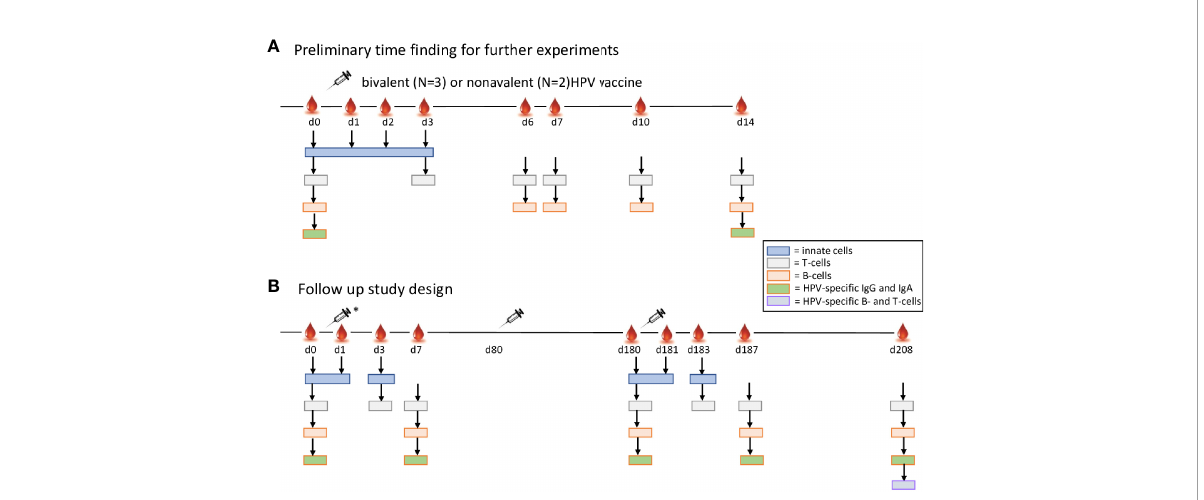
FIGURE 1 Study design. Adult healthy pre-menopausal women (n=20) seronegative for HPV16/18/31/45 received either the bivalent or the nonavalent HPV vaccine according to a three-dose schedule, the second vaccination at 1 month and the third vaccination at 6 months. (A) In the preliminary experiments a blood sample was taken just before vaccination (day 0), and after the fi rst vaccination at day 1, 2, 3, 6, 7, 10 and 14. Numbers of subsets of innate cells (blue), T cells (green), and B cells (red) were studied in 3 bivalent and 2 nonvalent recipients. The arrows indicate the speci fi c time points used per cell type. (B) In the follow up (*) blood samples were drawn of the other 7 bivalent and 8 nonavalent vaccine recipients just before vaccination (day 0), and after the fi rst vaccination at day 1, 3, and 7. At two months a second vaccination was given to all 20 study participants (N=10 per cohort). After 6 months (day 180) the third vaccination was given and blood samples were drawn at day 181 (1 day), 183 (3 days), 187 (7 days) and 208 (28 days post third vaccination. At day 0, 7, 180, 187 and 208 HPV IgG serum antibodies speci fi c for HPV16/18/31 and 45 were determined. At 28 days post third vaccination (day 208) PBMCs were isolated for studying HPV-type speci fi c memory B cells and T-cell